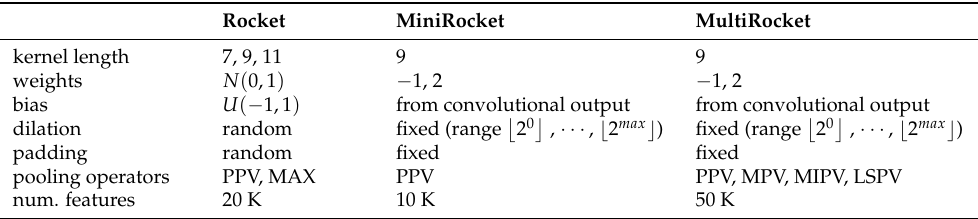
Table 1. Summary of changes from Rocket to MiniRocket and then to